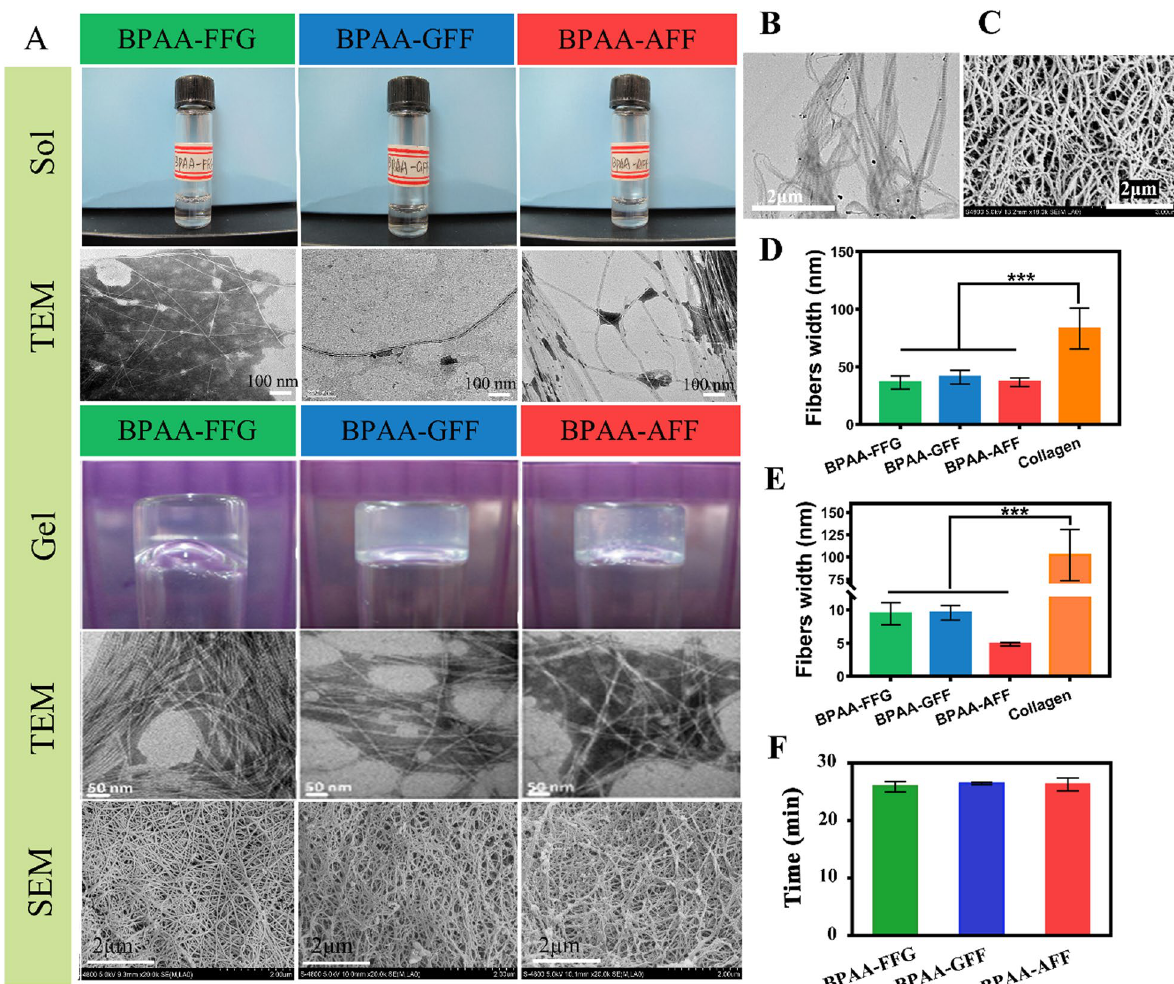
Fig. 2 A The optical and TEM images of BPAA-FFG, BPAA-GFF and BPAA-AFF sols along with the optical, TEM and SEM images of BPAA-FFG, BPAA-GFF and BPAA-AFF gels. B The TEM image of collagen. C The SEM image of collagen. D The fiber width obtained from SEM of BPAA-FFG, BPAA-GFF, BPAA-AFF and collagen. E The fiber width obtained from TEM images. F The gelation time of BPAA-FFG, BPAA-GFF and BPAA-AFF